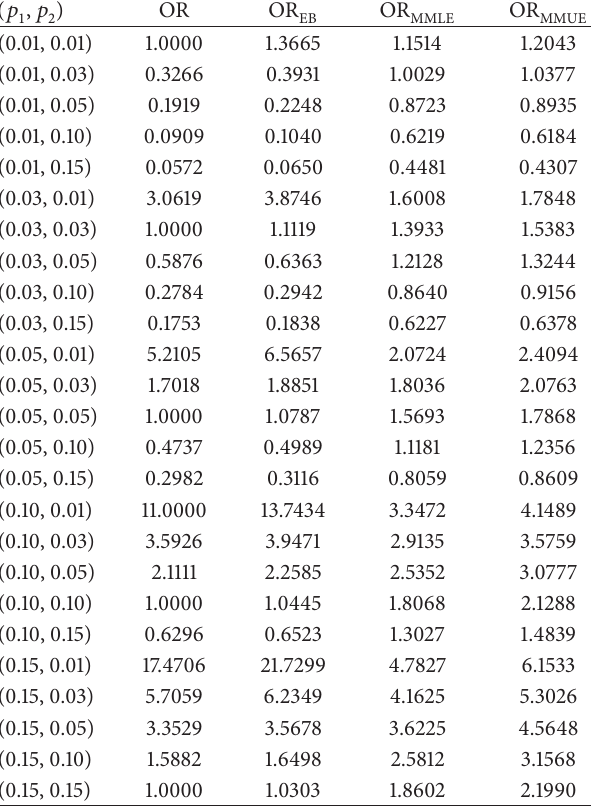
Table 1: The estimated values of odds ratio for (𝑛 1 ,𝑛 2 ) = (10,